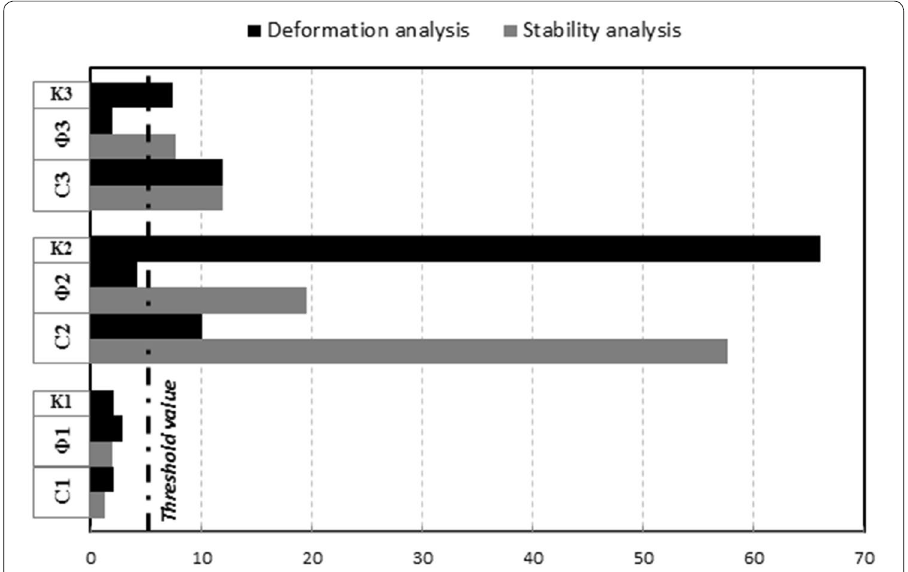
Fig. 4 Relative sensitivity of basic variables for both deformation and stability analysis